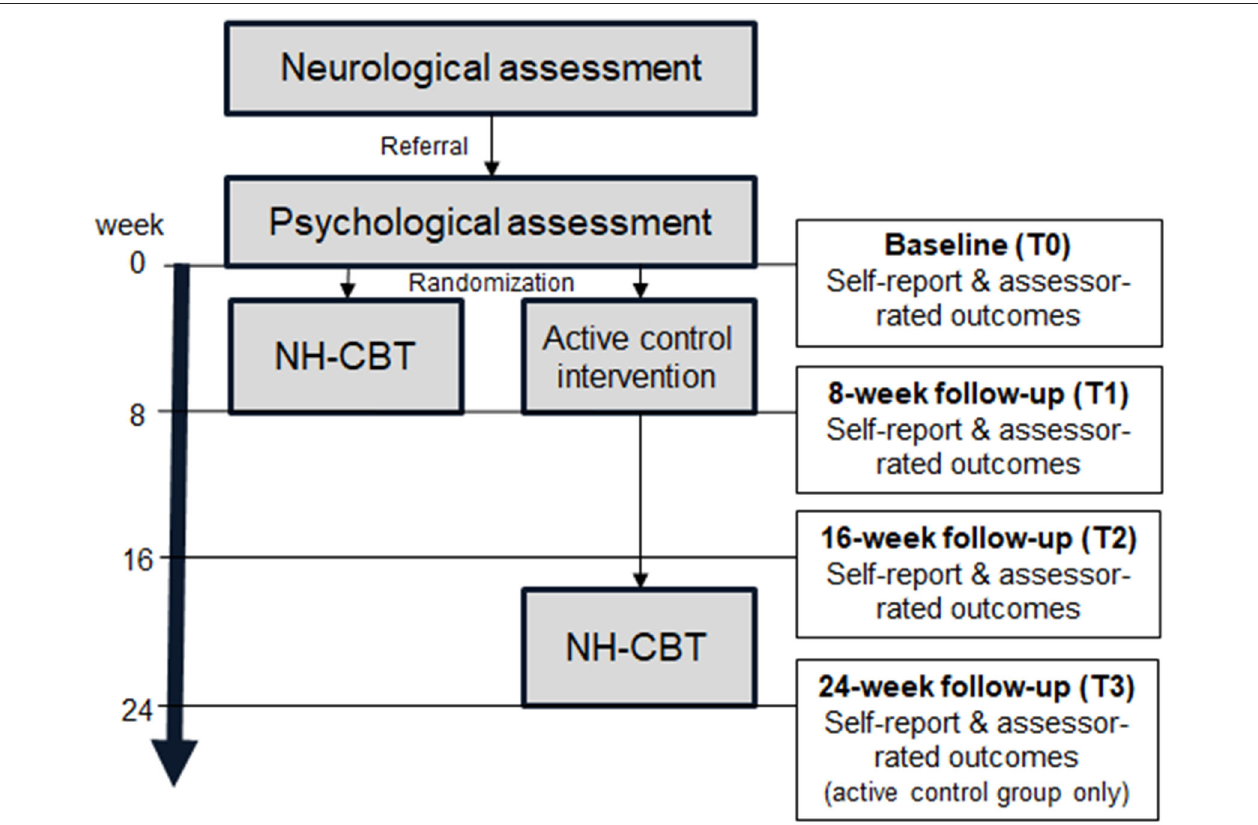
FIGURE 1 | Flow chart of the study procedure and outcome assessments (NH-CBT, Nocebo-Hypothesis Cognitive Behavioral Therapy).